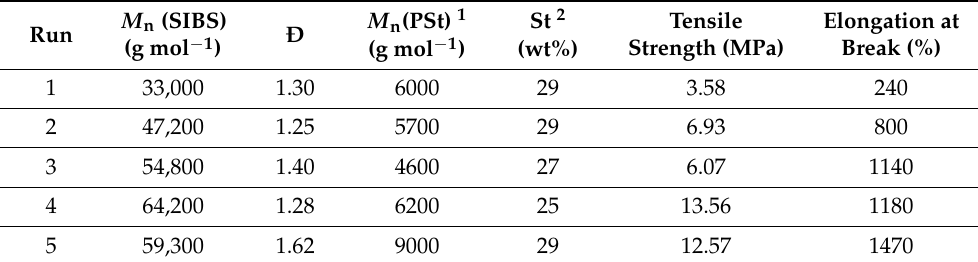
Table 2. Tensile properties of SIBS triblock copolymers of different composition at 24 °C.